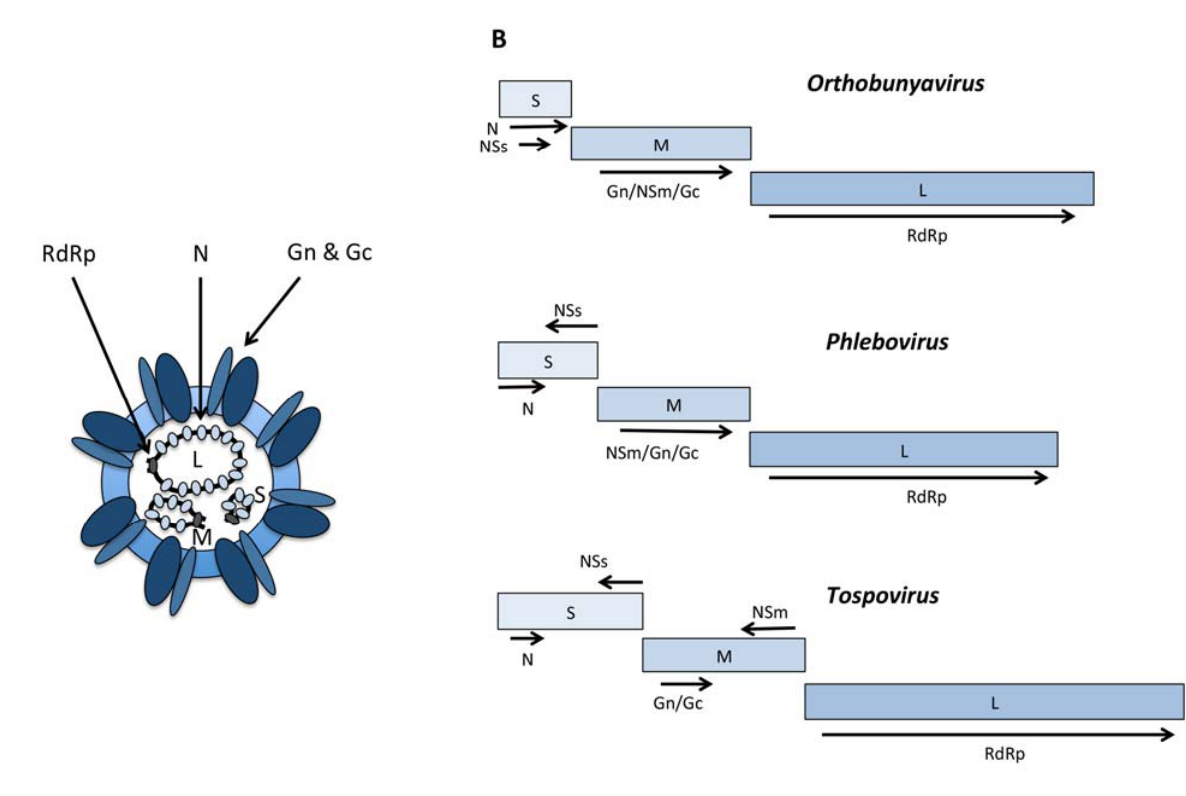
Figure 1. Virion structure and genetic organization of bunyaviruses. ( A ) The virion containing the three RNA segments (L, M and S) encapsidated by the N protein. ( B ) Genetic organization of the three bunyavirus genera discussed in the paper. Arrows depict the position of open reading frames (arrows below box, open reading frames in mRNAs transcribed from genome; arrows above box, open reading frames in mRNAs transcribed from